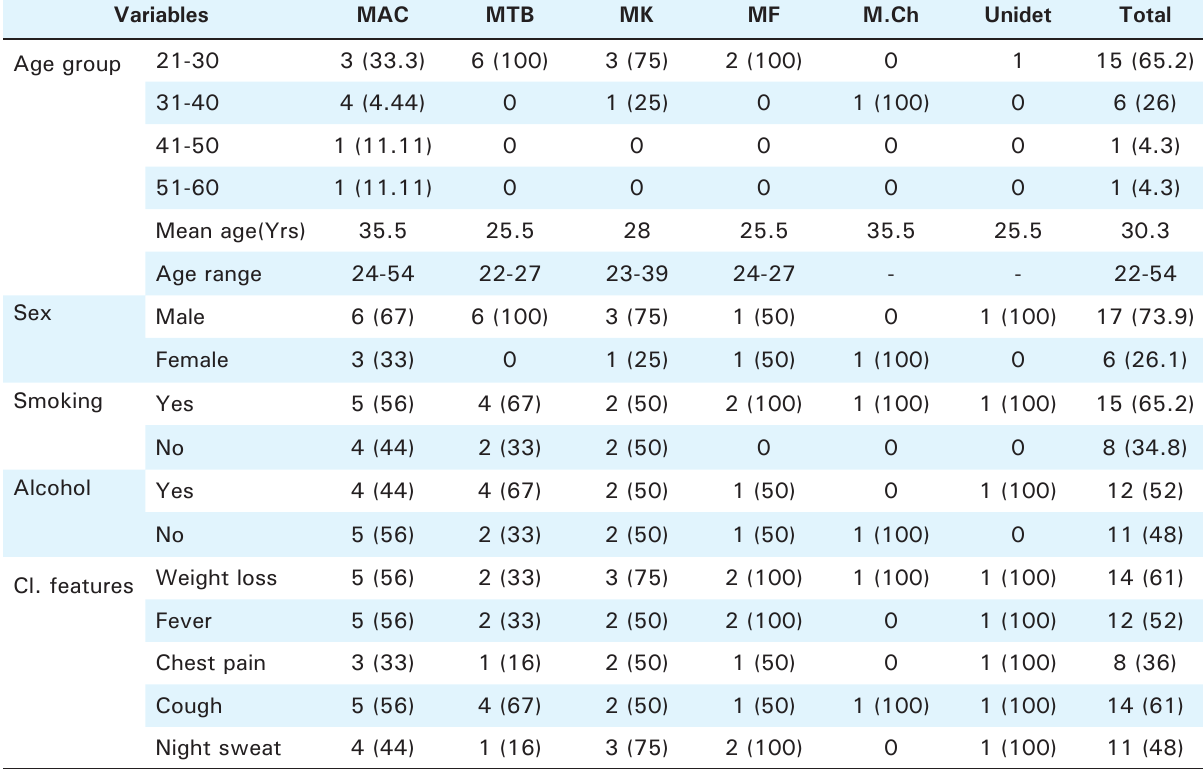
Table 4. Sociodemographic Characteristics and Clinical Features of Co-infected Cases.